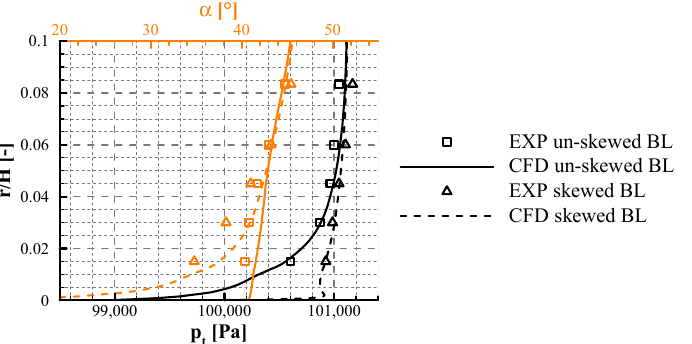
Figure 2. Pitchwise averaged total pressure p t (black) and flow angle α (orange) upstream of S1 (MP4) in the hub endwall region, s/C = 2.0%, EXP vs. CFD.